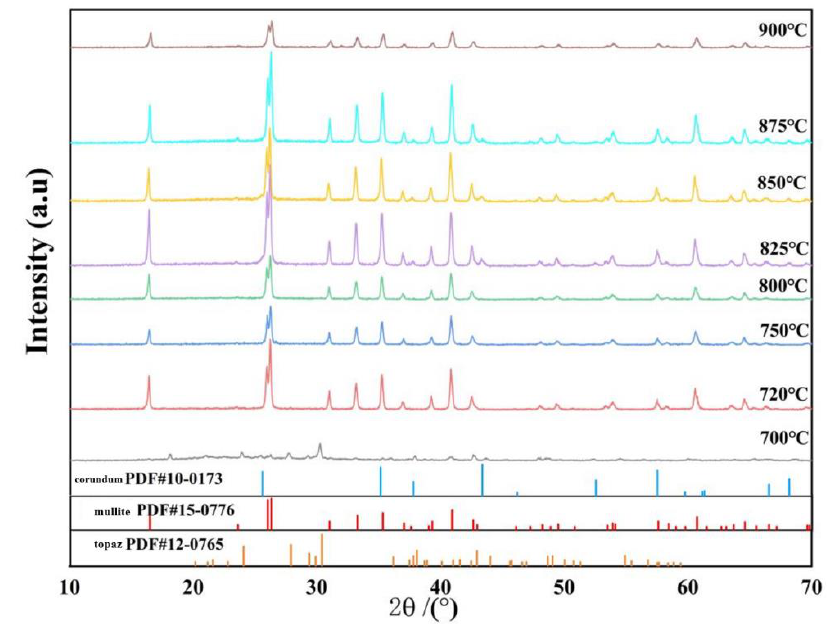
Figure 6. XRD patterns of samples sintered at 700–900 °C for 5 h.